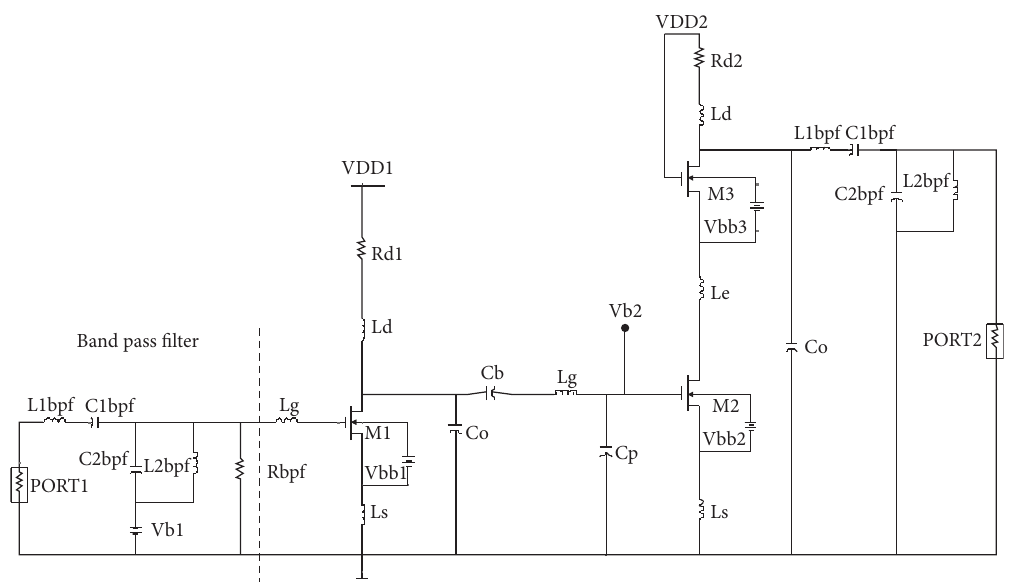
Figure 2: The proposed LNA.